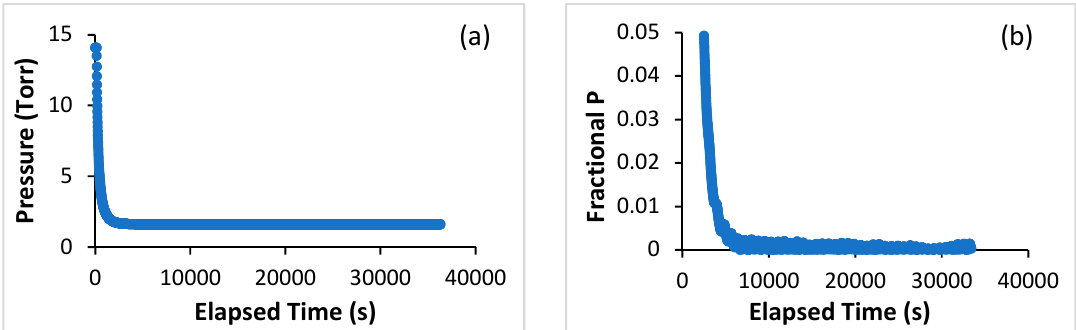
Figure 3. Approach to equilibrium for point 6 along the 82.07 K isotherm for Ar on the open nanohorns (the point numbers start at 1 with the point at the lowest loading, 2 for the next one, etc. ). ( a ) Absolute pressure (in Torr, Y axis) as a function of the time elapsed (in seconds) since a dose of gas was added; and ( b ) fractional pressure distance to equilibrium [(P(t) − P eq )/P eq ] as a function of time elapsed since dosing (data shown for ( b ) start ~40 min after the dose was added). From ( b ) it is clear that the noise level in the pressure is reached only after ~2 h have elapsed.